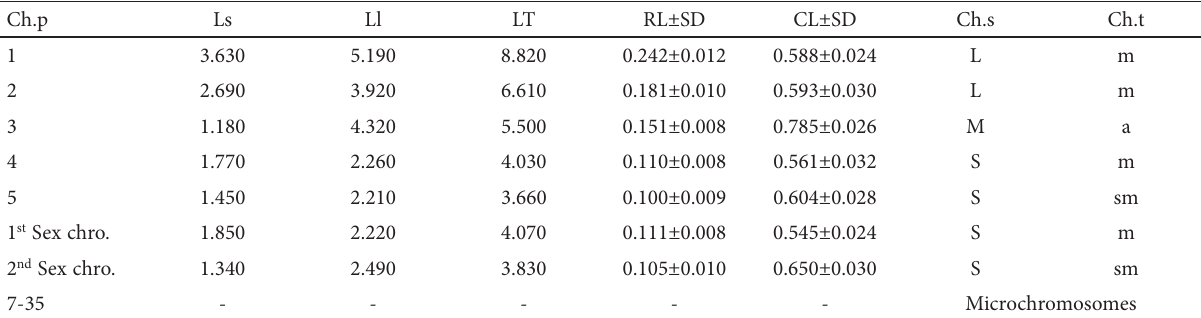
Table 1. Mean length of short arm chromosome (Ls), long arm chromosome (Ll), total arm chromosome (LT), relative length (RL), centro- meric index (CI), and standard deviation (SD) of RL, CI from 20 metaphase cells of two female individuals spotted dove ( Spilopelia chinen- sis ), 2 n =70.